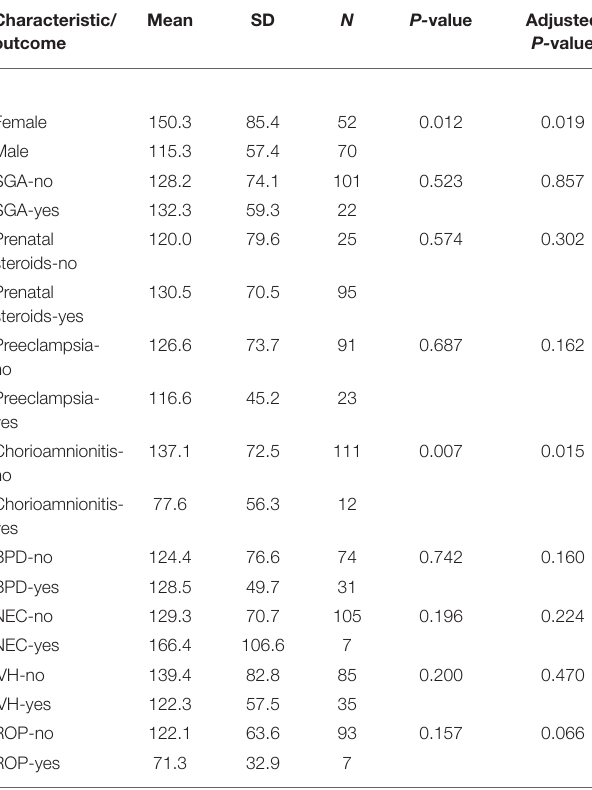
TABLE 2 | Plasma concentrations of amino acids ( µ mol/L) in preterm infants with and without PDA. Amino acid PDA status